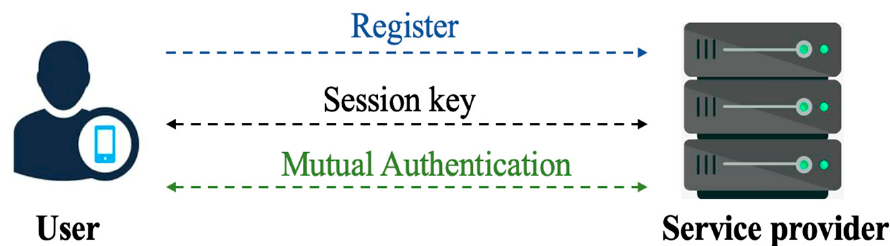
Figure 1. System model of 2FA protocol.